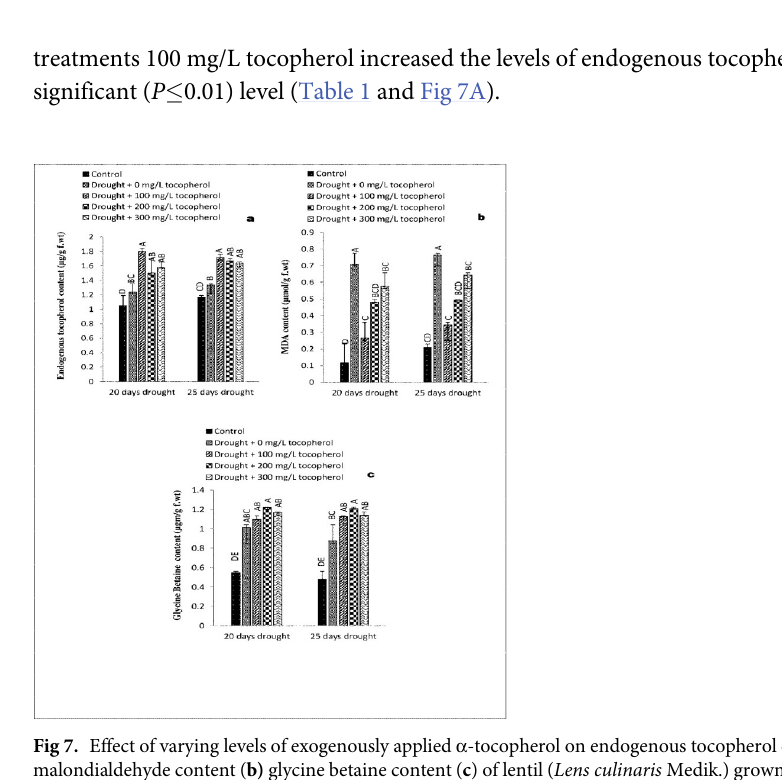
Fig 7. Effect of varying levels of exogenously applied α -tocopherol on endogenous tocopherol content ( a) malondialdehyde content ( b) glycine betaine content ( c ) of lentil ( Lens culinaris Medik.) grown under varying drought stress condition (Mean ± standard error.) letters (A–E) indicating least significance difference among the mean values at p � 0.05.